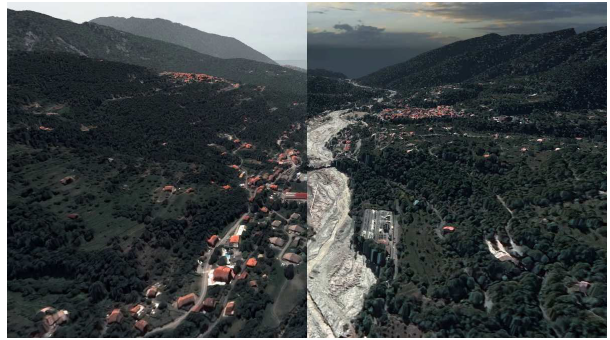
Fig. 4. QUB 3D multi temporal scene – Split view of 2019 & 2020 Vésubie valley (flood damages on the right picture)